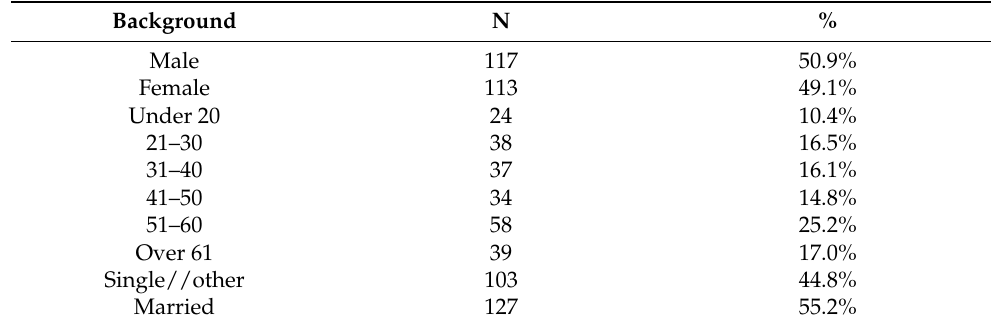
Table 2. Analysis of demographic variables.